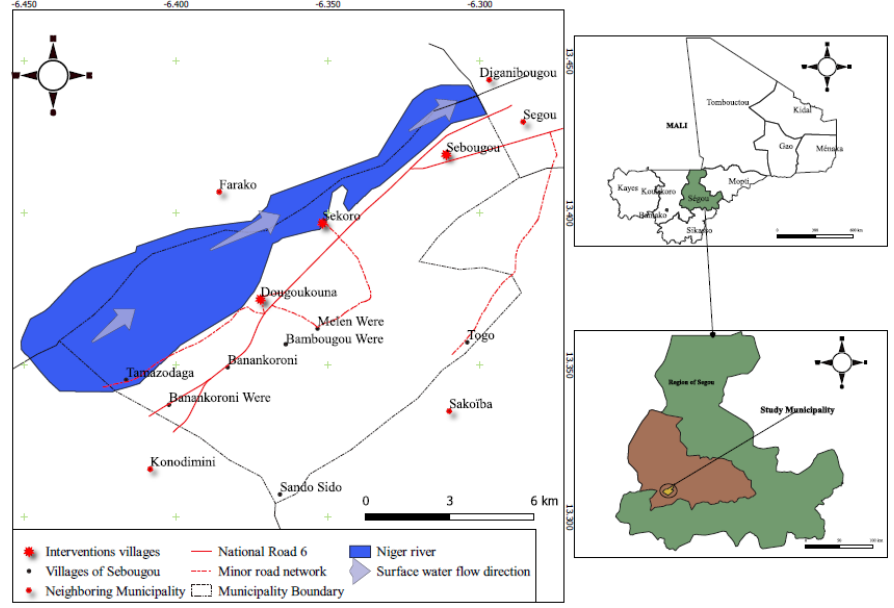
Figure 1. Map of the study area.